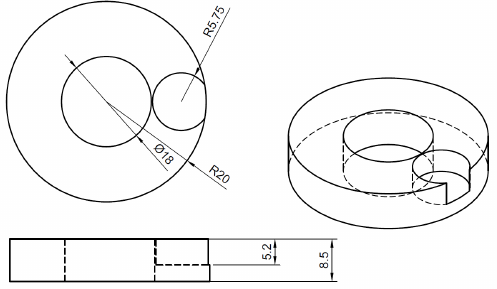
Figure 12. Schematic representation of the Teflon-bearing used under the 50-teeth gears. Sizes shown are just for reference and have not been optimized. The design will require